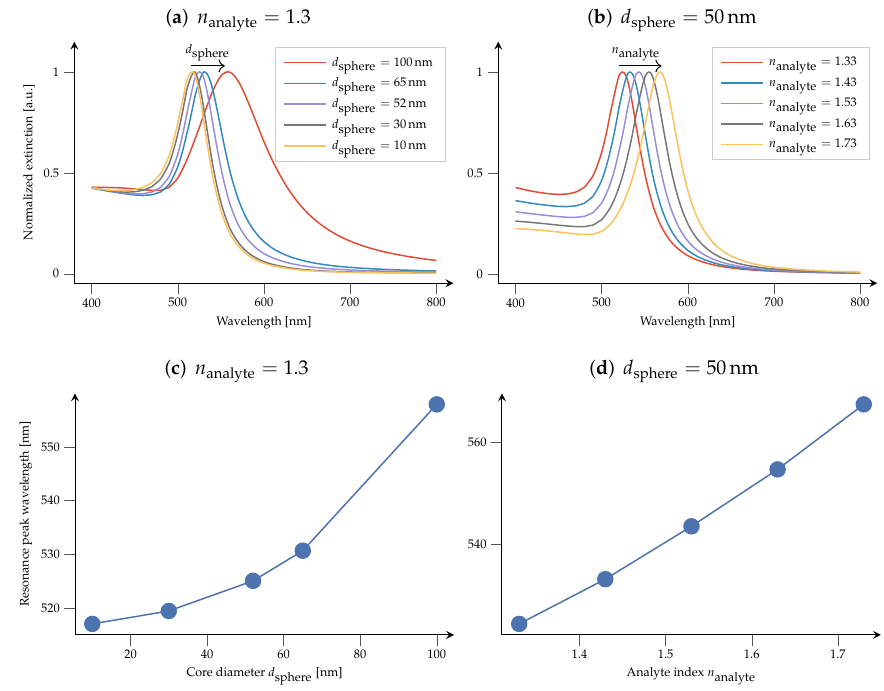
Figure 7. Visualising the parameter variation effect of gold spheres dispersed in an analyte. Extinction resonance shift for ( a ): changing sphere diameter, dispersed in water ( n analyte = 1.33), and ( b ): for constant-diameter ( d sphere = 50nm) spheres, and varying analyte index n analyte . ( c , d ) showcase the extracted resonance peak wavelengths for the experiments shown in ( a , b ),